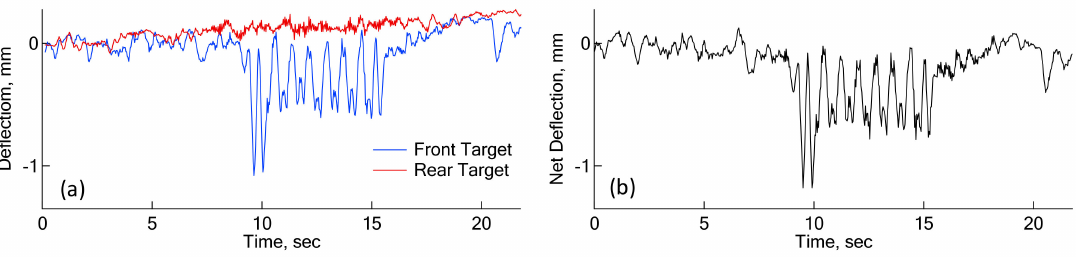
Figure 9. Deflections determined from Canny edge detection technique: ( a ) deflections of front and rear targets; ( b ) net deflections between front and rear